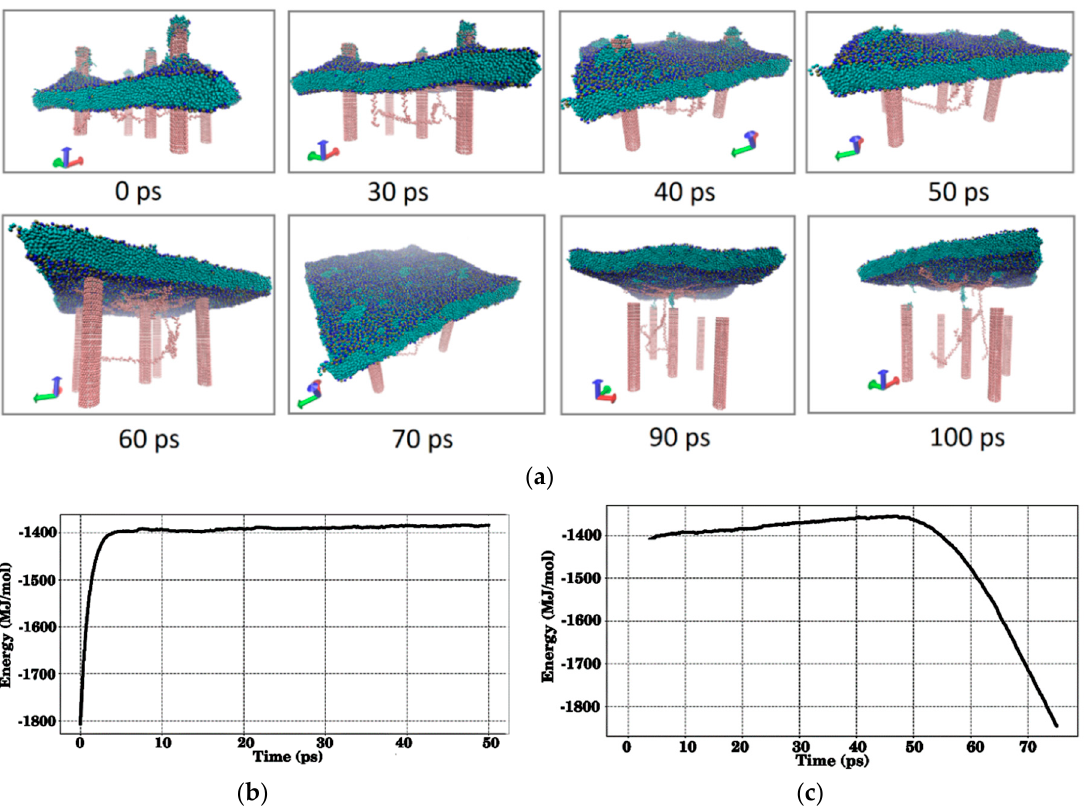
Figure 8. The interaction of the membrane with the CNT–chitosan polymer matrix: ( a ) Snapshots of the process of detachment of the membrane from the surface of the matrix; ( b ) a plot of change in the energy of the matrix + membrane system when the membrane falls on the matrix; ( c ) a plot of change in the energy of the matrix + membrane system when the membrane detaches from the matrix and its backward movement from the matrix (CNTs and chitosan filaments are marked in pink, the membrane is marked in green and blue).